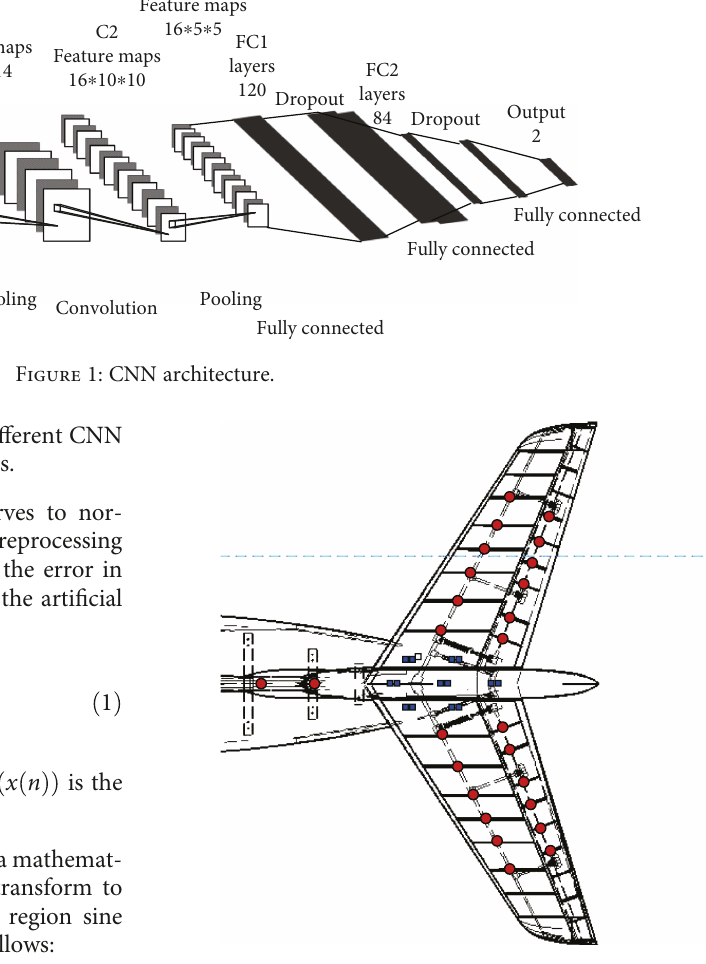
Figure 2: Sensor positions in the aeroelastic